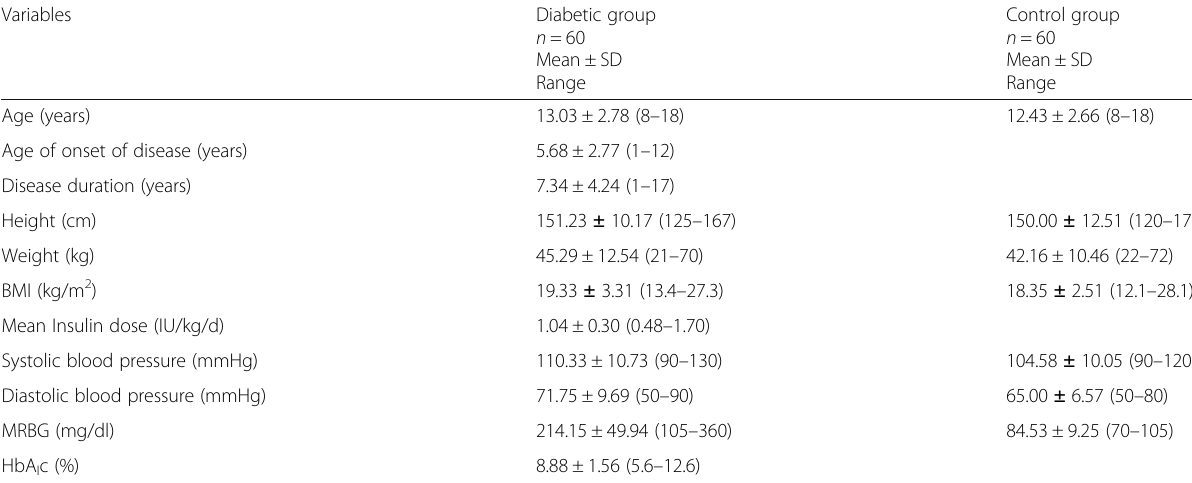
Table 1 Some important descriptive demographic, clinical, and laboratory data of the studied diabetic and control groups